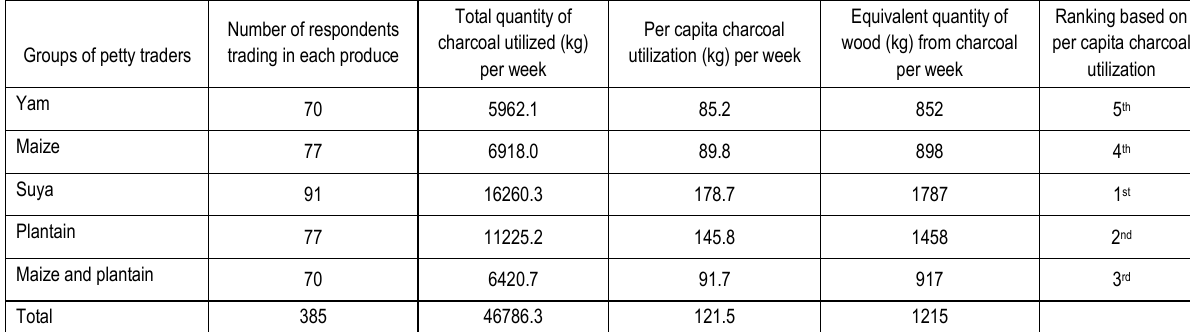
Table 5. Per capita charcoal utilization per week by the different categories of traders